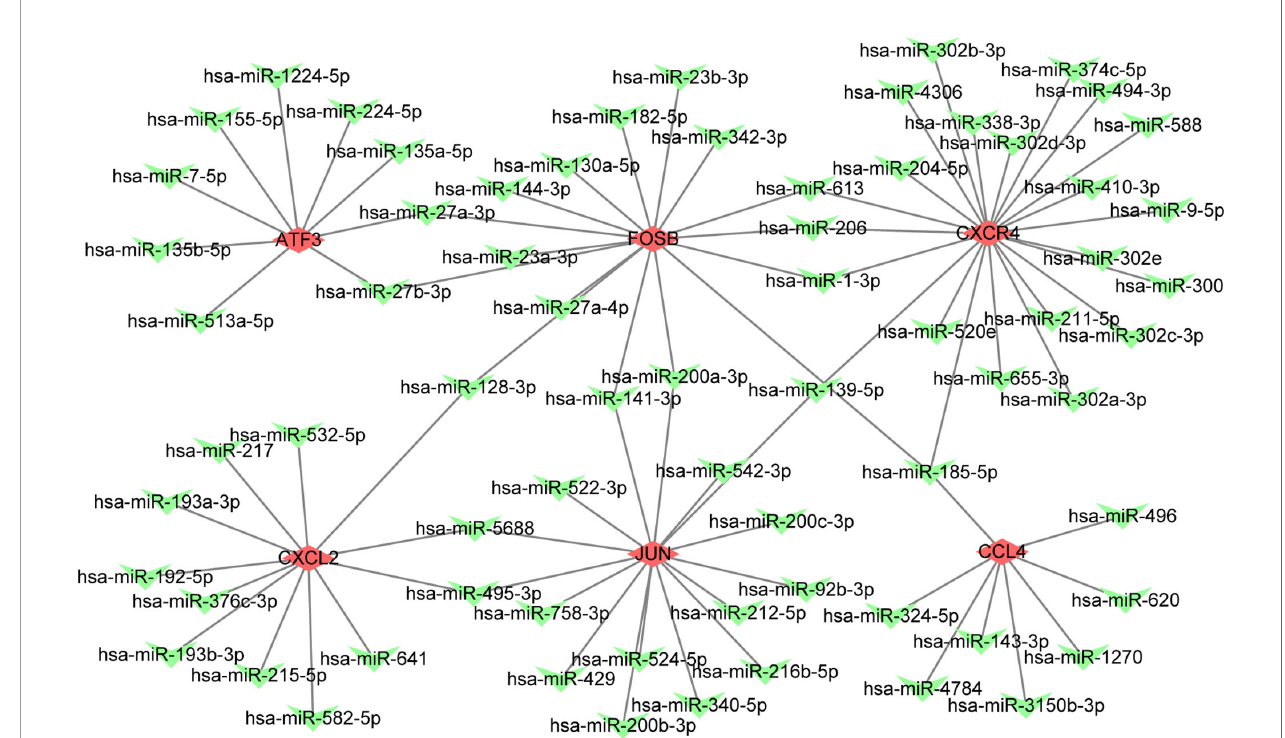
FIGURE 4 | The constructed mRNA-miRNA network. The green heart represents the downregulated genes, the red diamond represents the